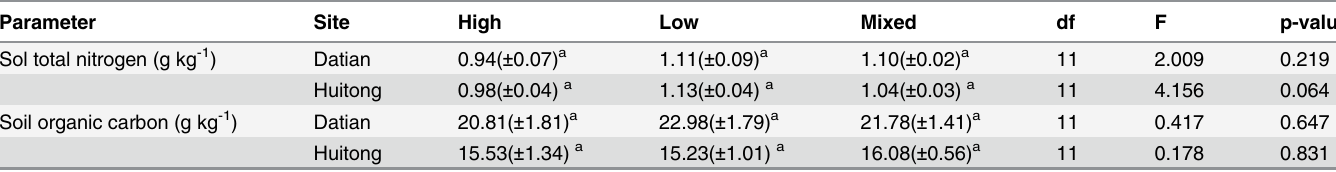
The stand types are single-species C . lanceolata with high basal area (High), single-species C . lanceolata with low basal area (Low), mixed C . lanceolata and S . superba / M . macclurei (Mixed). Same letters indicate not signi fi cant at P <